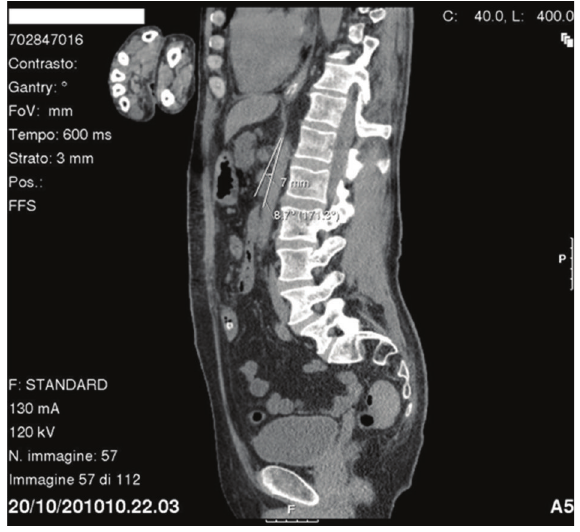
Figure 3: Sagittal CT image demonstrating the aortomesenteric